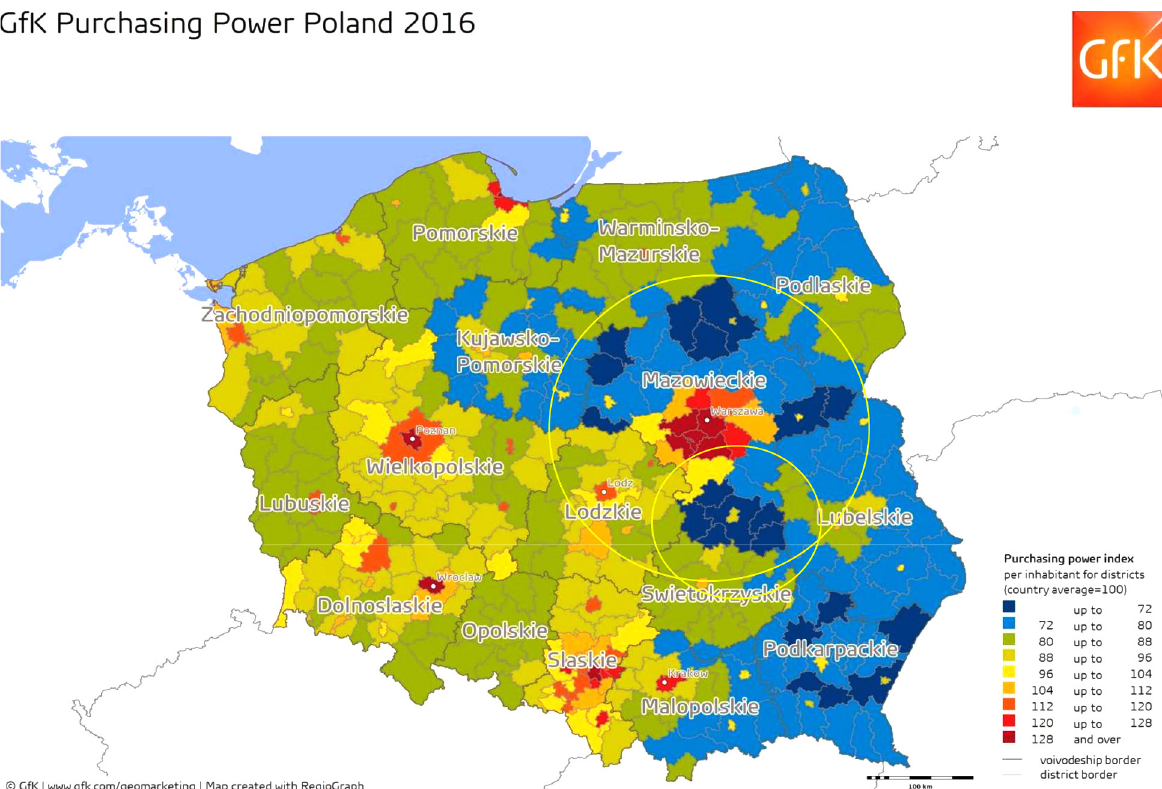
Fig. 1. Purchasing power of Polish subregions, 2016. Radom subregion and Mazovia Province are marked in yellow circles. Source: Gfk (2019), own